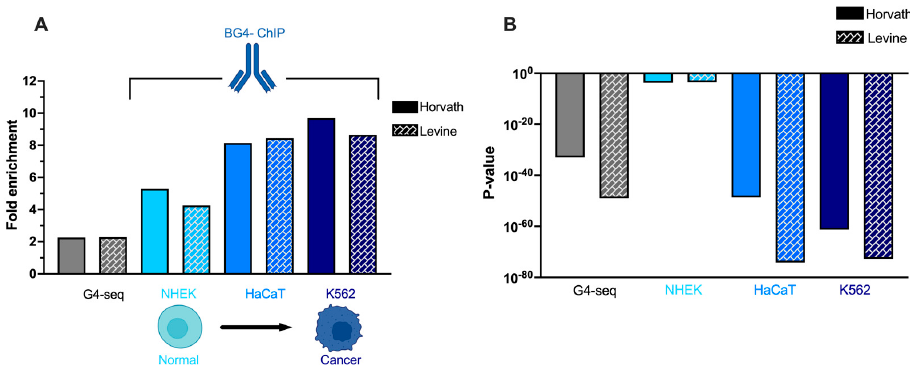
Figure 5. (A ) Enrichment (relative to global CpG enrichment) of human G4s within 1000 bp of Horvath and Levine ageing clocks sites including enrichment from G4-seq data, as well as cell-based BG4-ChIP experiments in NHEK, HaCaT, and K562 cells. ( B ) Statistical significance of G4 enrichment within 1000 bp of Horvath and Levine ageing clocks found with G4-seq data and in NHEK, HaCaT, and K562 cells.